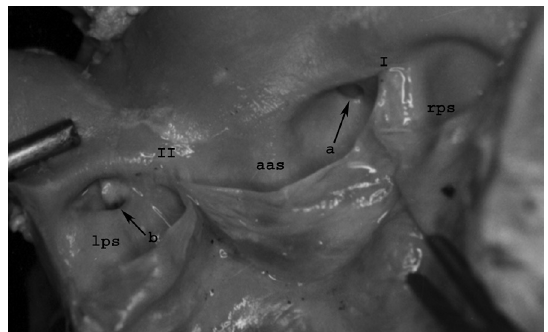
Figure 6 - The circumferential deviation of the right coronary ostium (arrow a) towards Commissure I. The left coronary ostium is similar to a horizontal slit. The margin of the slit has been lifted and the lower margin is at arrow b. Aas - anterior aortic sinus; lps - left posterior